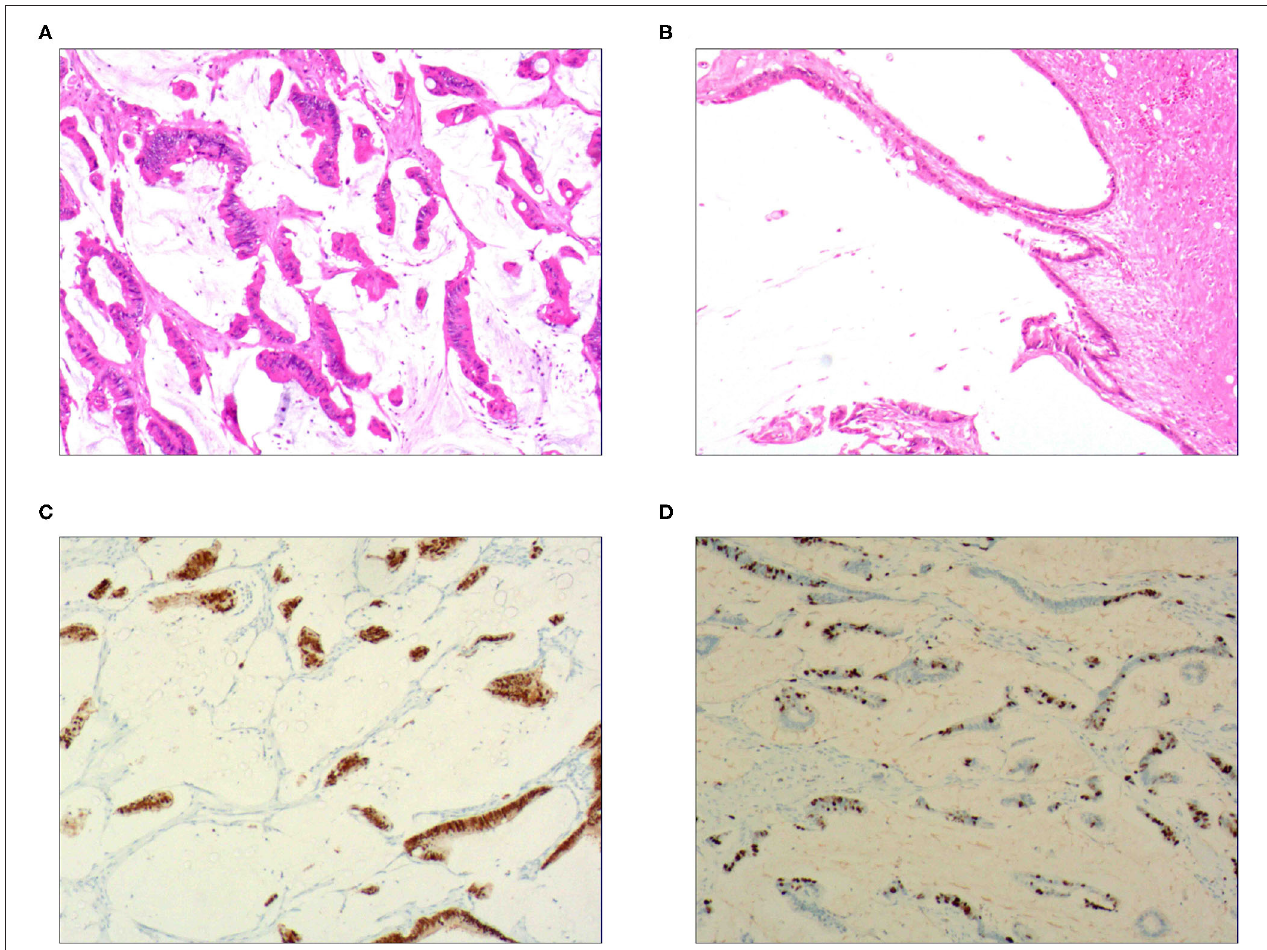
FIGURE 2 | Intraductal papillary mucinous carcinoma. (A) It was composed of differentiated tubular and papillary adenocarcinoma tissues and mucinous tissues; H&E staining, × 100. (B) The tumor’s primary invasion feature was to penetrate the periphery with propulsion type; H&E staining, × 100. (C) CDX2 was positively expressed in the differentiated adenocarcinoma cells; EnVision TM method, × 100. (D) . 50% of cells were positive for cell proliferation index Ki-67; EnVision TM method, ×